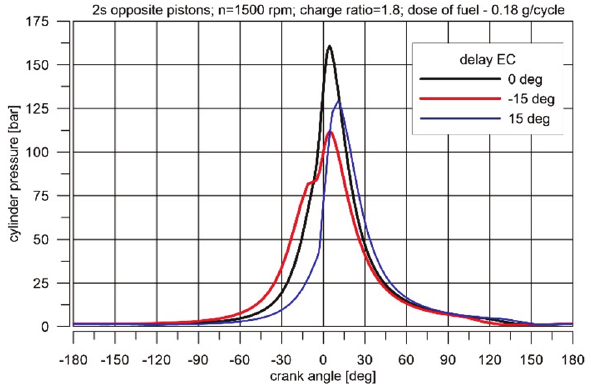
Fig. 11. Cylinder pressure variation in 2sOPE for different delays of exhaust ports closing (EC) in function of crank angle